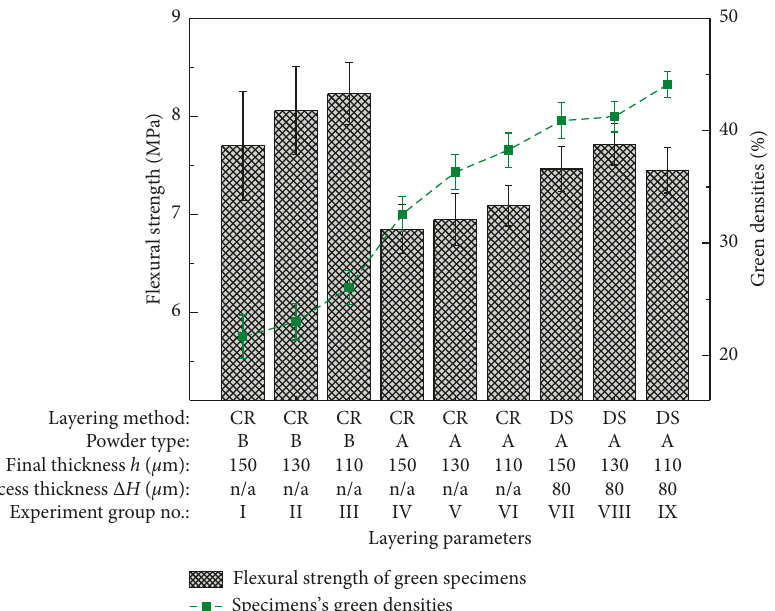
Figure 10: Flexural strength and initial green densities of the printed